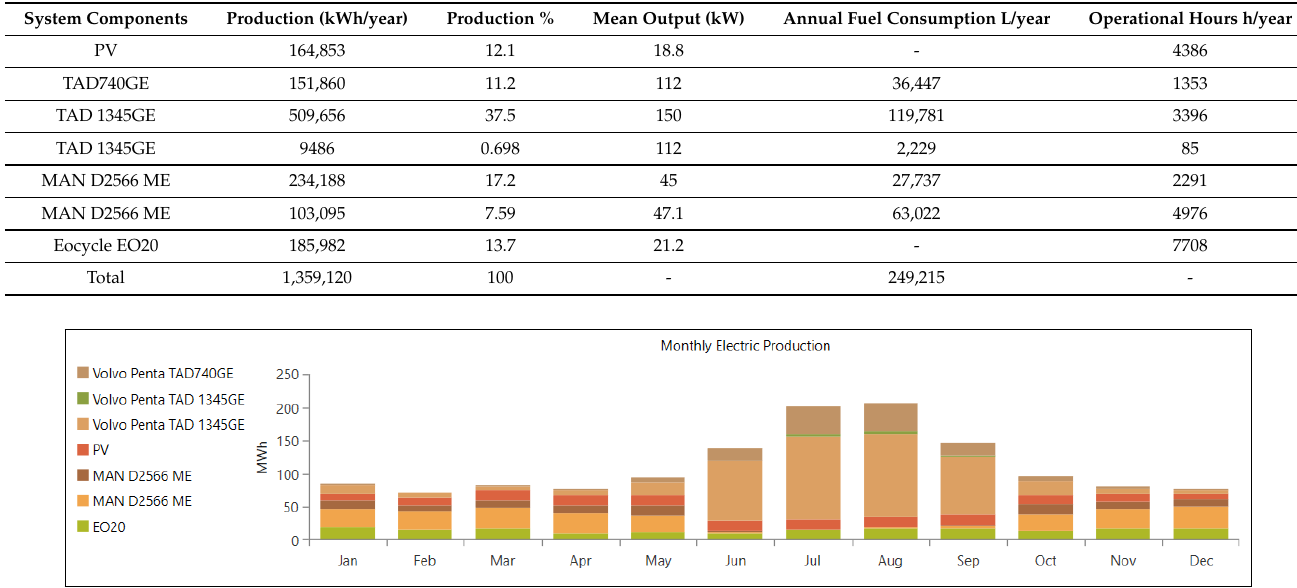
Figure 8. Monthly Electrical Production of Scenario